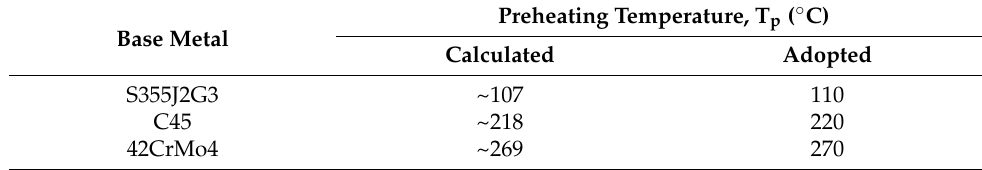
Table 5. The preheating temperatures of the tested steels.